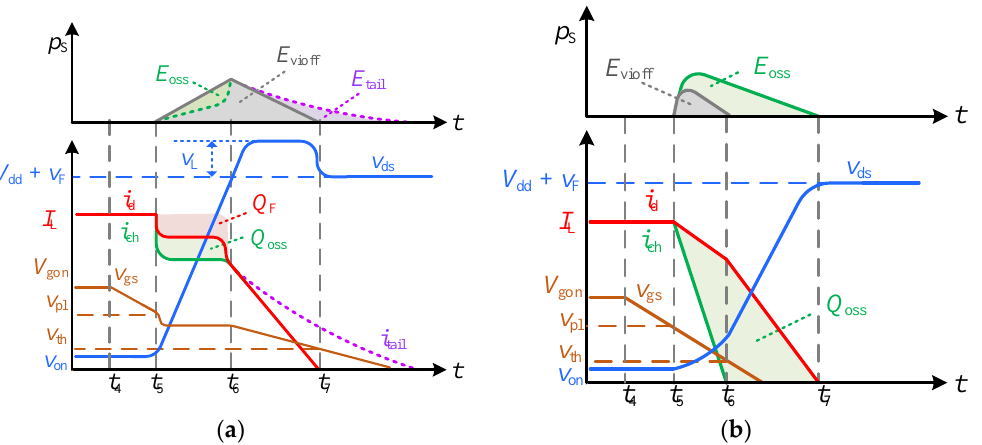
Figure 5. Typical turn off waveforms for 𝑆 as ( a ) Si IGBT or Si/SiC MOSFETs; ( b ) Typical eGaN HEMT.